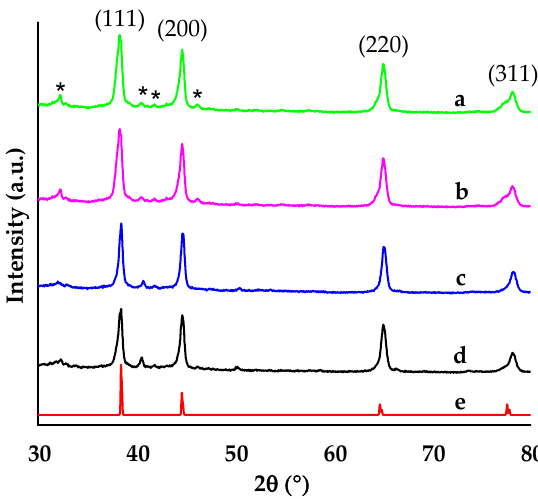
Figure 6. X-ray diffraction pattern of AgNPs produced by: ( a ) WT-1.250 mM; ( b ) CWD-1.250 mM; ( c ) WT-0.625 mM; ( d ) CWD-0.625 mM; and ( e ) Ag metal. * These may be attributed to the salts of the BBM culture media.